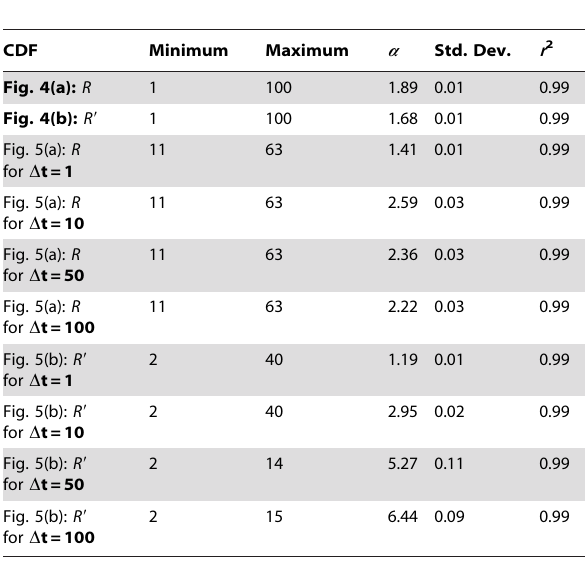
Table 3. The parameters for fitting CDFs shown in Figs. 4 and 5 (SH index in the Chinese stock market) with R or R 9 ranging from ‘‘Minimum’’ to